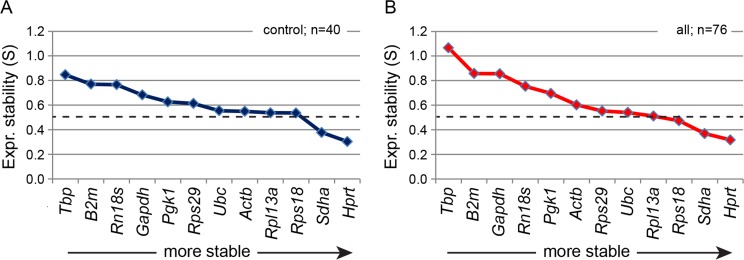
Relative expression stability (S) of 12 reference genes across rat tissues as determined by NormFinder.The 12 reference genes were assayed across (A) control tissues (n = 40) from juvenile and adult rats and (B) the control tissues plus adult tissues from rats subjected to chemical exposures (n = 76). The tissues included prostate, testis, adrenal, liver, fat, and ovary. Higher S-values represent lower expression stability, with S < 0.5 typically indicating relative stability suitable for use as endogenous normalization. The data show a shift towards higher S-values (B vs. A) for the most unstable gene transcripts following chemical exposure.